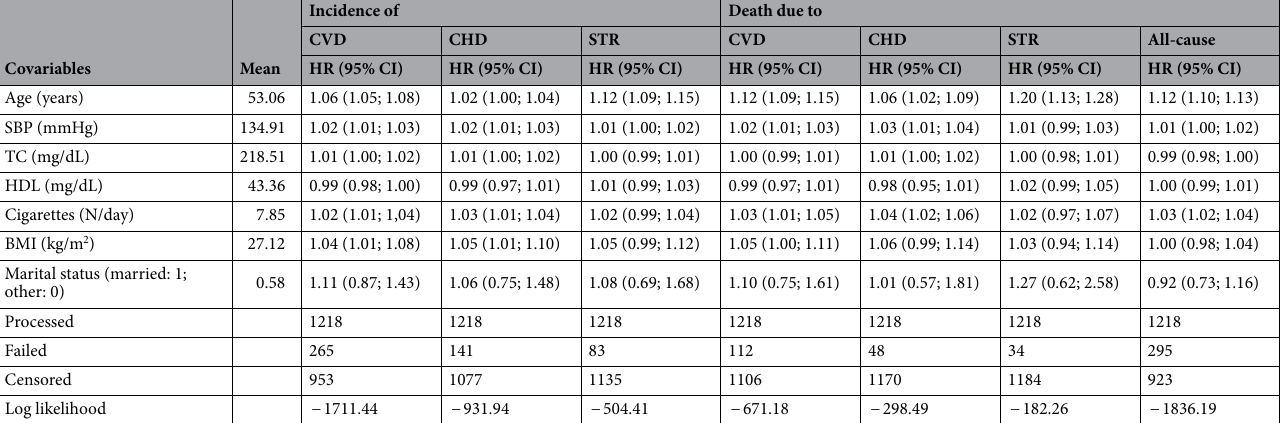
Table 3. Hazard ratios (HR) and 95% confidence intervals (CI) of cox’s model solutions (Efron’s ties method), computed on units of covariates, to study association of many factors with incident events (fatal and non-fatal) or deaths in all-men of the Gubbio Population Study during 191 months of median follow-up. SBP systolic blood pressure (the average between the second and third measurement), TC total cholesterol, HDL high- density lipoprotein cholesterol, BMI body mass index, CVD cardiovascular diseases by hard criteria, CHD coronary heart disease by hard criteria, STR